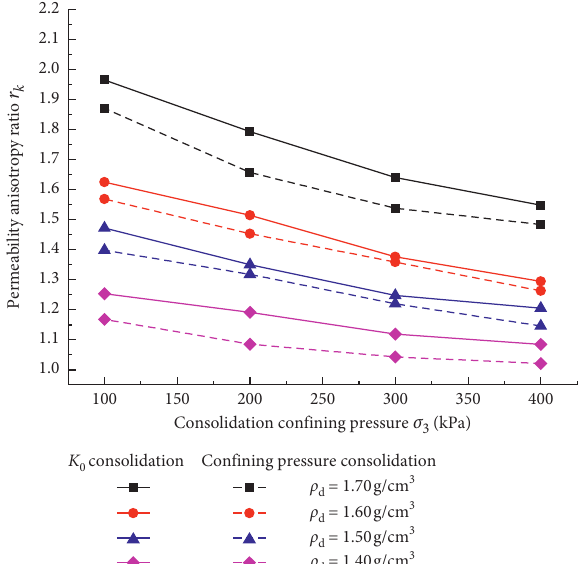
Figure 14: Saturated permeability anisotropy ratio of compacted loess under K